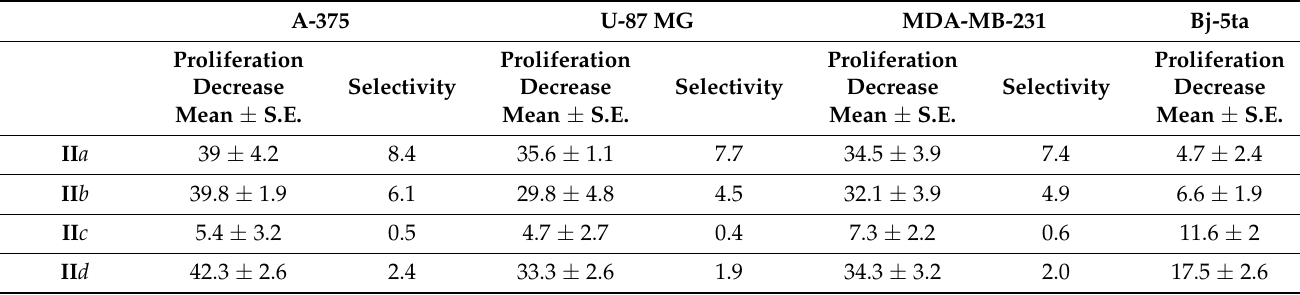
Table 2. Selectivity of the aryl carbamate II cytotoxicity for the percent of proliferation decrease at the compound concentration of 100 µM. Incubation time 20 h, MTT assay data, percent of proliferation decrease, mean ± standard error ( n = 5 experiments). Selectivity was calculated as the anti-proliferative activity ratio for the appropriate cell line to the anti-proliferative activity for the Bj-5ta cell line. ND, not defined.